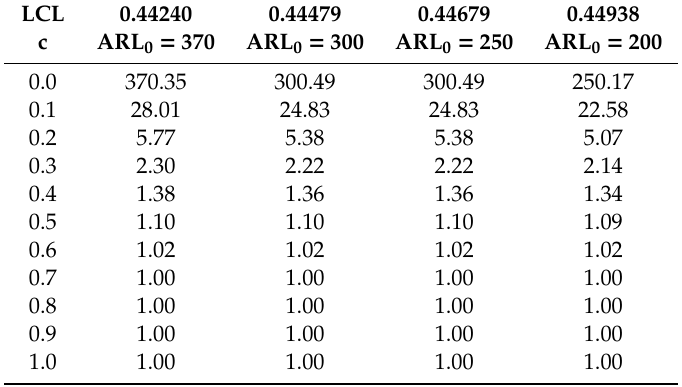
Table 6. The ARLs for the proposed chart when n = 50, WD (1.0,1.3), USL = 6.8878, and LSL =